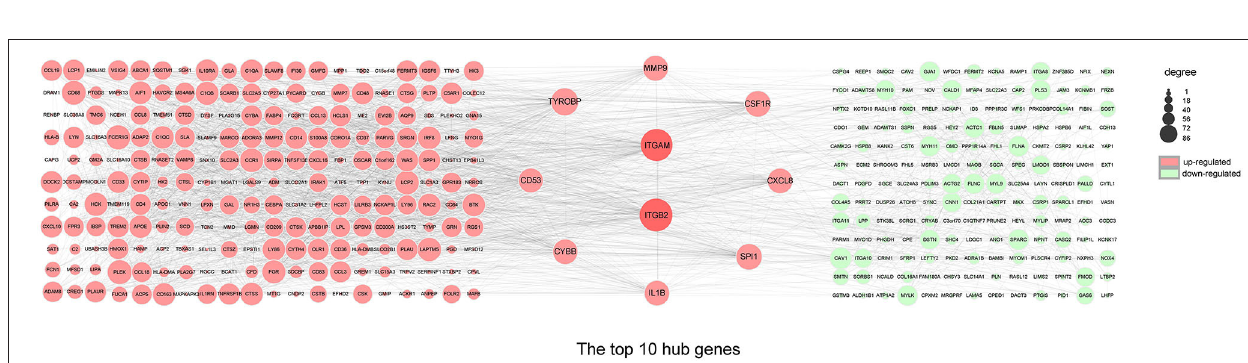
FIGURE 5 | PPI network and hub genes. The PPI network analyzed by the STRING database. The top 10 hub genes screened by the degree method using CytoHubba plugin (Cytoscape). The size of the circle from small (lower) to large (higher) represents the ranking. Red and green represent upregulated and downregulated genes, respectively. DEGs, differentially expressed genes; ITGB2 , integrin subunit beta 2; ITGAM , integrin subunit alpha M; TYROBP , transmembrane immune signaling adaptor TYROBP; SPI1 , Spi-1 proto-oncogene; CSF1R , colony stimulating factor 1 receptor; MMP9 , matrix metallopeptidase 9; CXCL8 , C-X-C motif chemokine ligand 8; IL1B , interleukin 1 beta; CYBB , cytochrome b-245 beta chain; CD53 , CD53